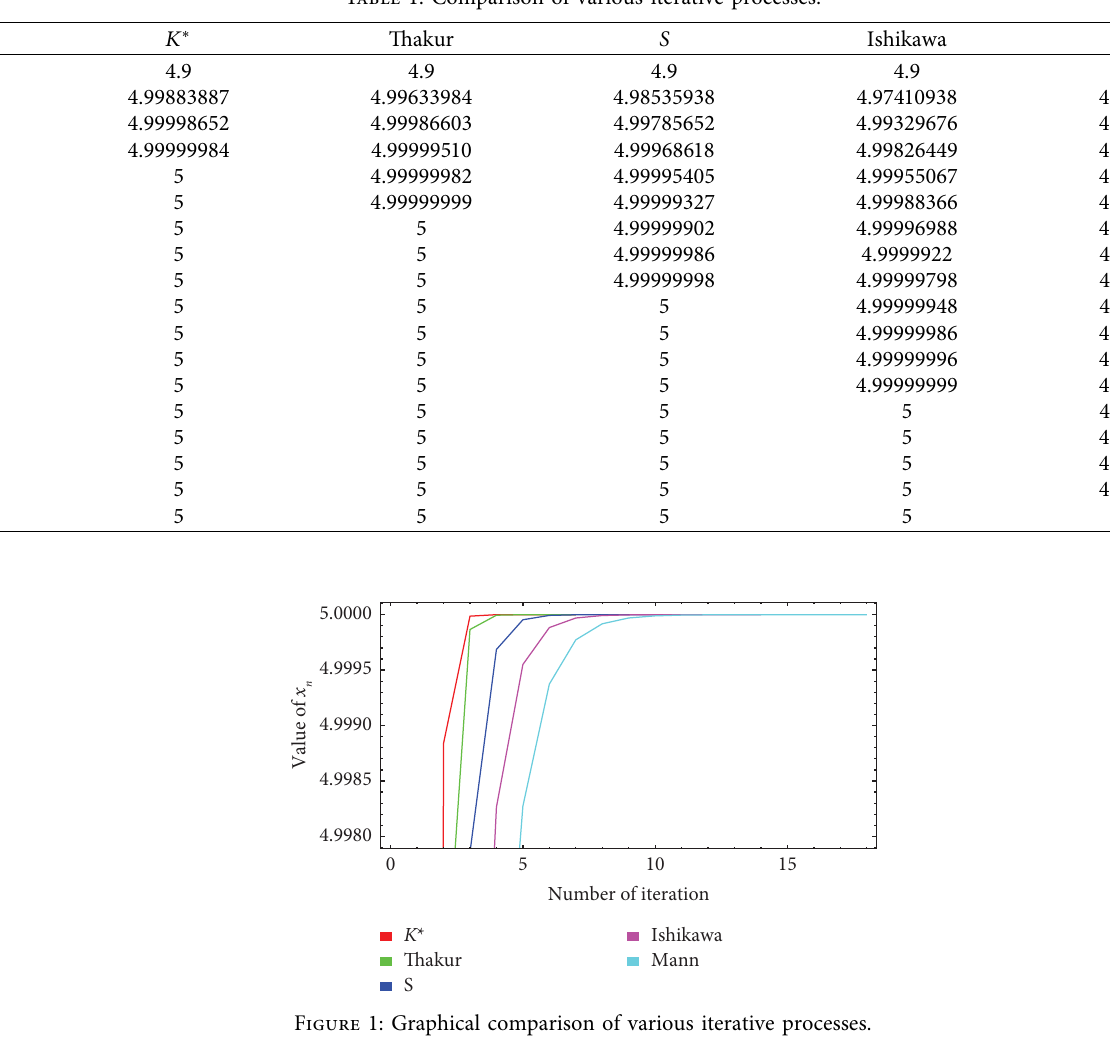
Table 1: Comparison of various iterative processes.